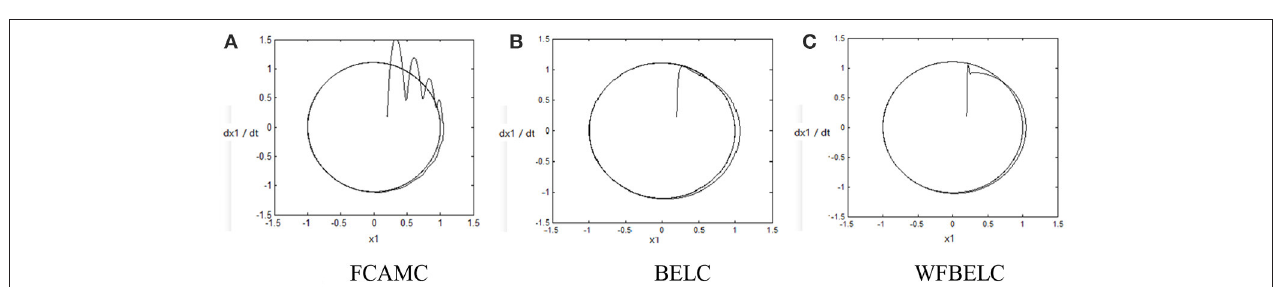
Frontiers in Neuroscience |